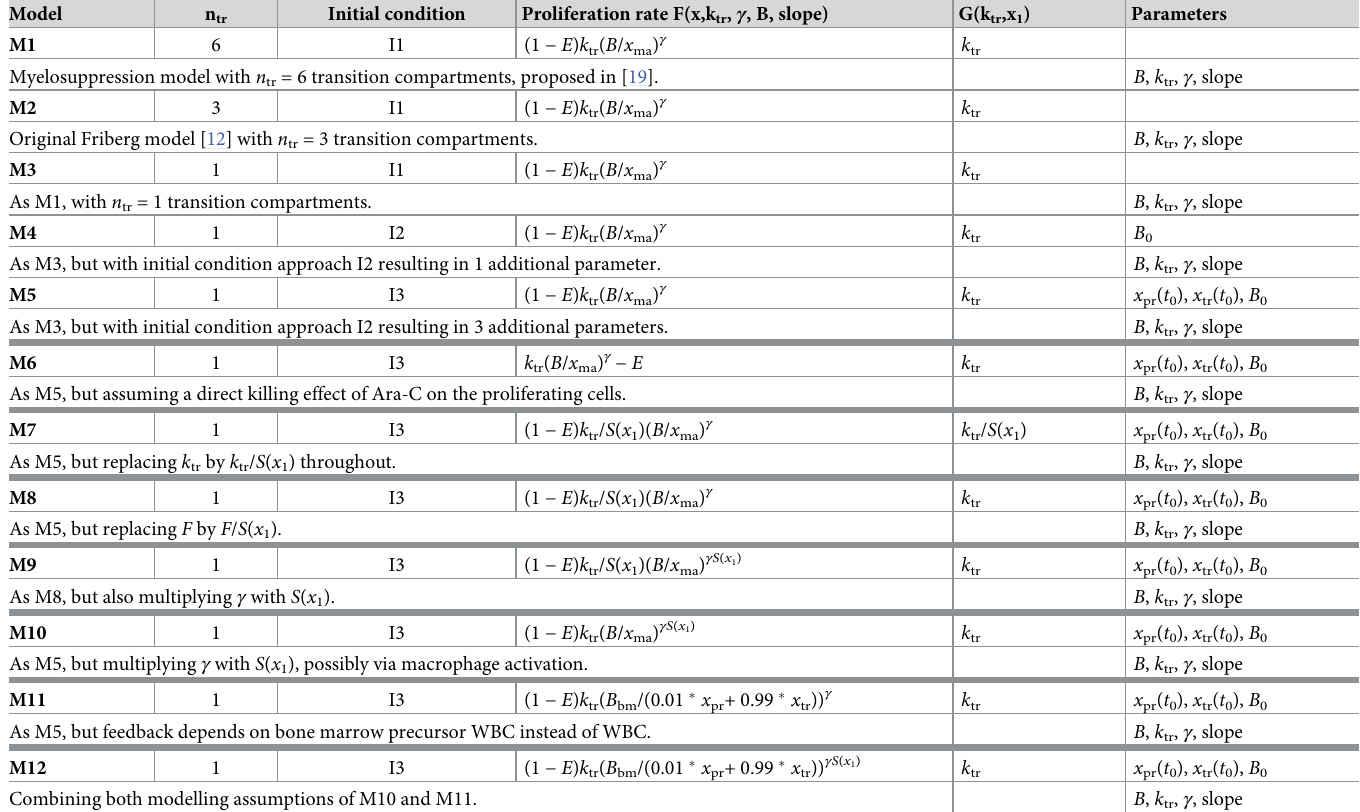
Table 1. Overview of all investigated mathematical models